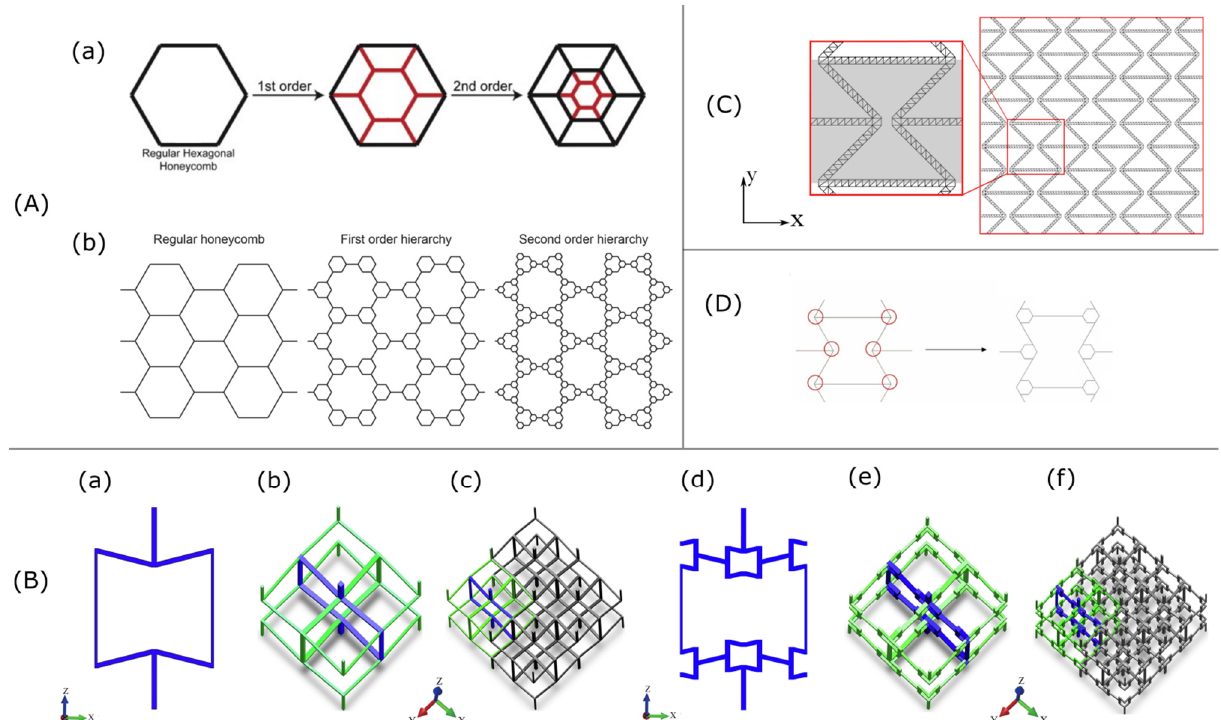
Figure 4. Hierarchical structures. ( A ): ( a ) Spiderweb structure [60] and ( b ) schematic showing the evolution of a regular hexagonal honeycomb and its corresponding cell into first and second orders of hierarchy [61]. ( B ): The schematics of re-entrant and hierarchical honeycomb structures: ( a , d ) unit cell in 2D, ( b , e ) unit cell in 3D and ( c , f ) the single-layer consisting of four cells [64]. ( C ): Globally auxetic lattice with minimally rigid sub-lattice [65]. ( D ): Modification of a conventional re-entrant unit cell (zero-order) to a first-order hierarchical unit cell [66].